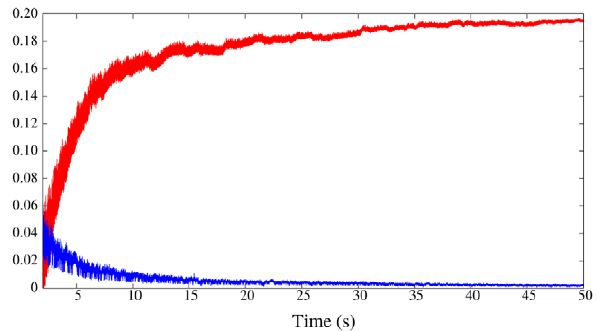
Figure 4. Lyapunov exponents calculated from WLC behavior. Evolution in the calculation of the two positive Lyapunov exponents in the statocyst model under the action of the hunting neuron. The existence of two positive Lyapunov exponents means that the activity